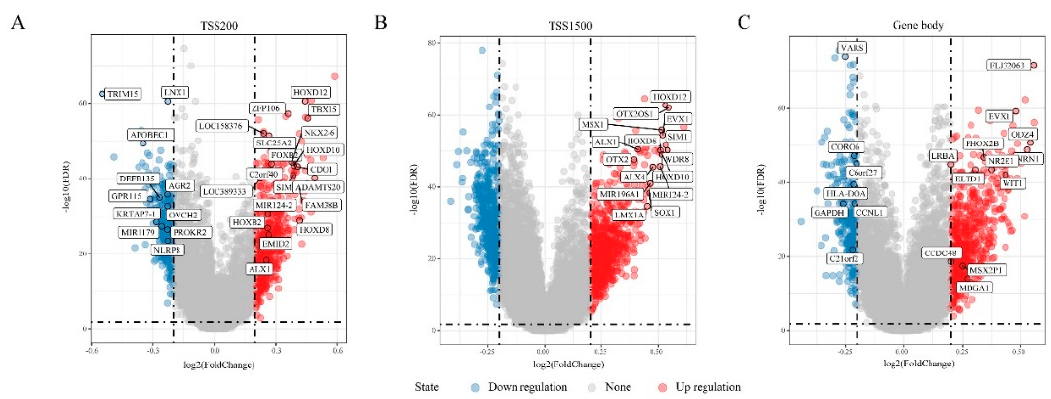
Figure 1. Cont. Figure 1.